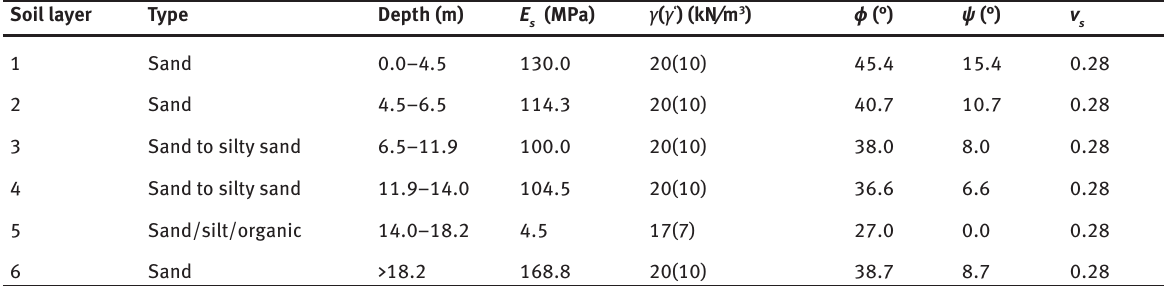
Table 2: Soil strata for each soil layer at Horns